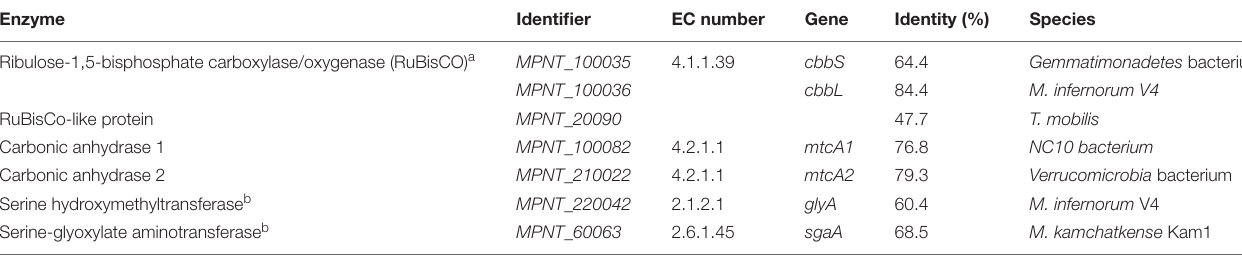
TABLE 4 | Key enzymes for three major carbon assimilation pathways in methanotrophs. Enzyme